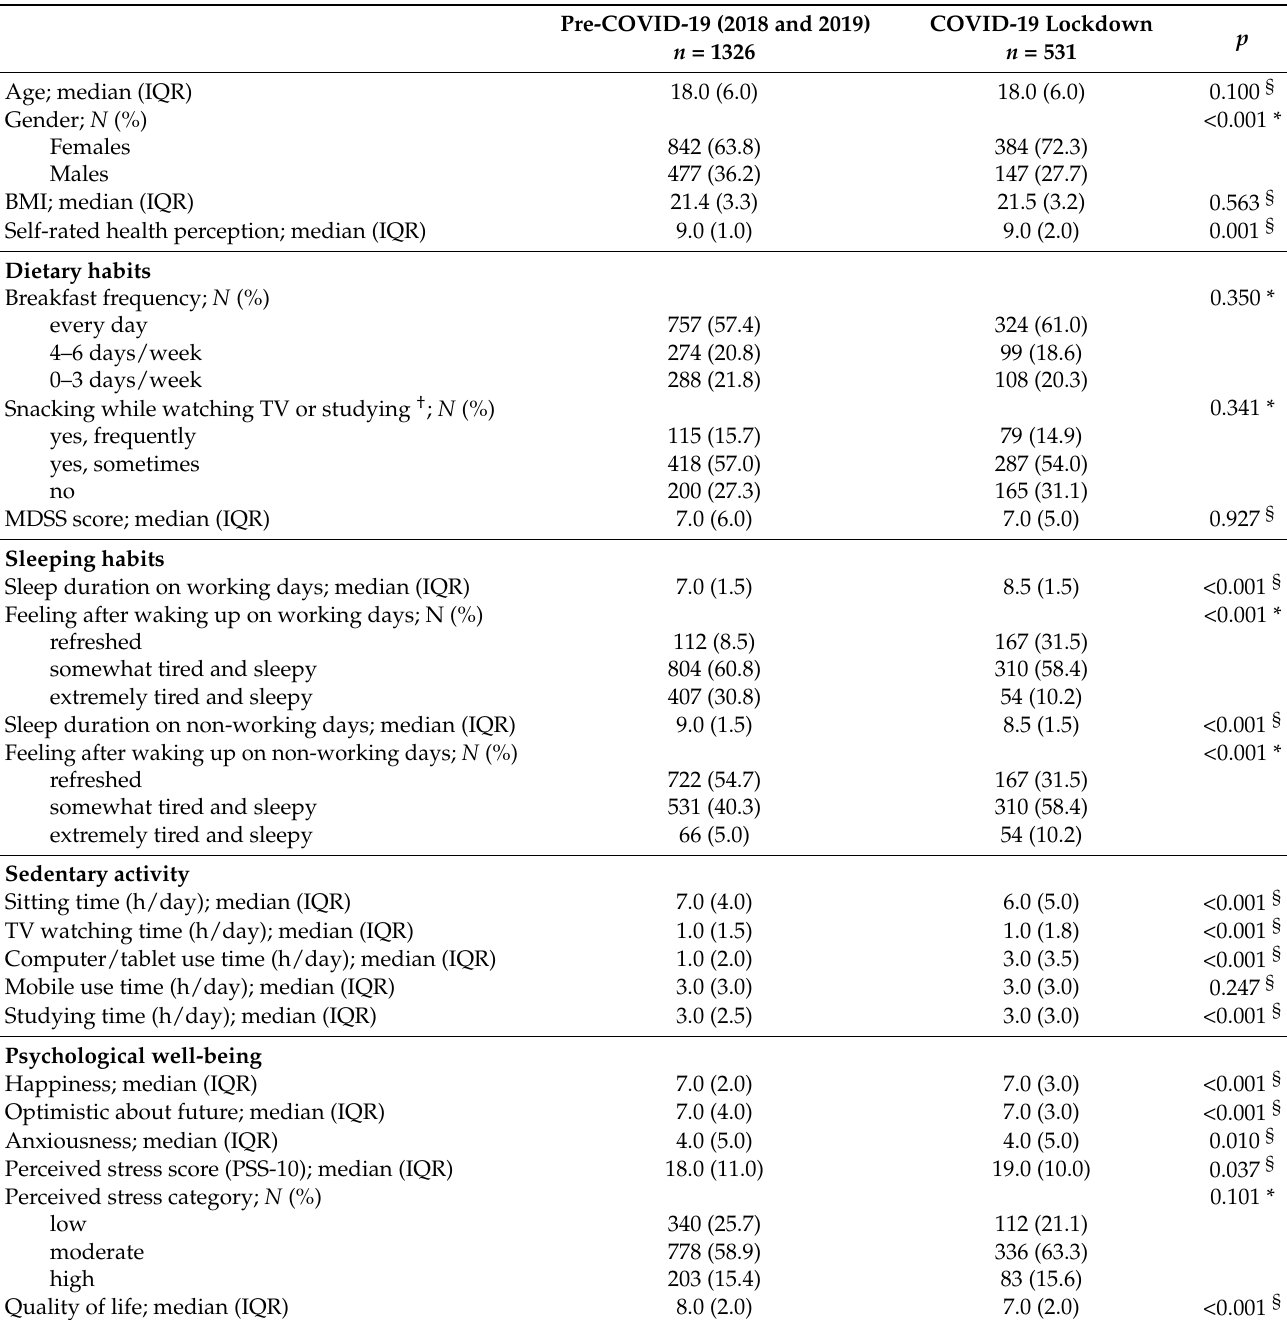
Table 2. Lifestyle habits before and during COVID-19 lockdown in the overall sample.